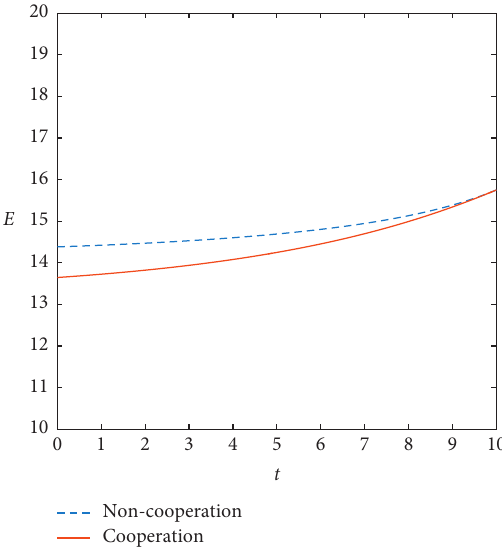
Figure 3: Optimal trajectory of pollution emission under coop- eration and non-cooperation when the planning period T � 10.